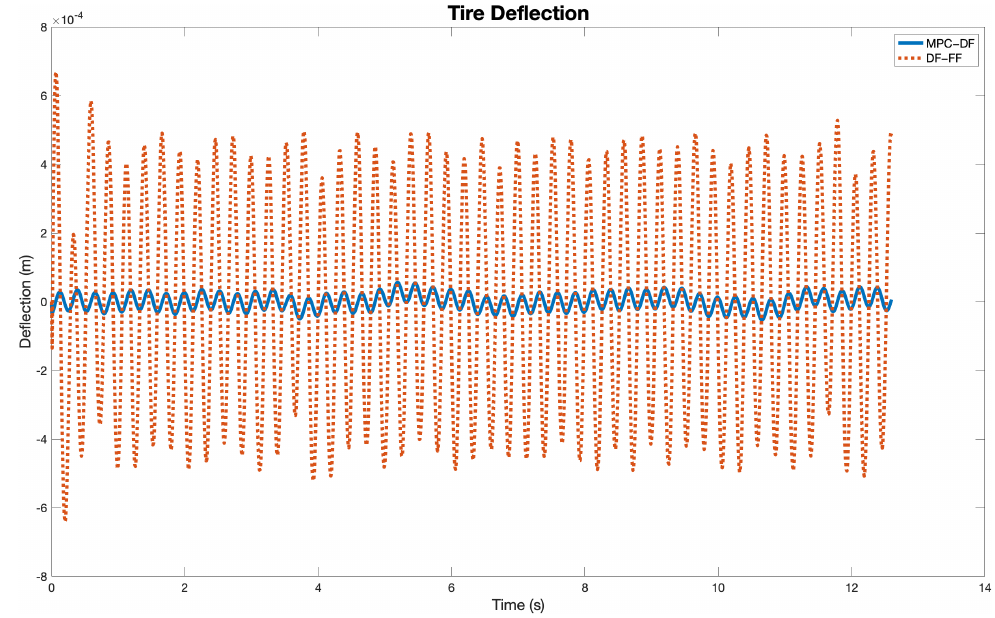
Figure 7. Tire Deflection (Blue–MPC-DF,